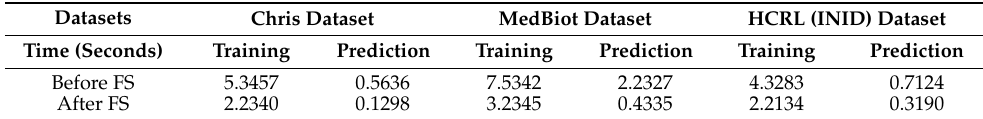
Table 6. Comparison of training and prediction time. FS: feature selection.